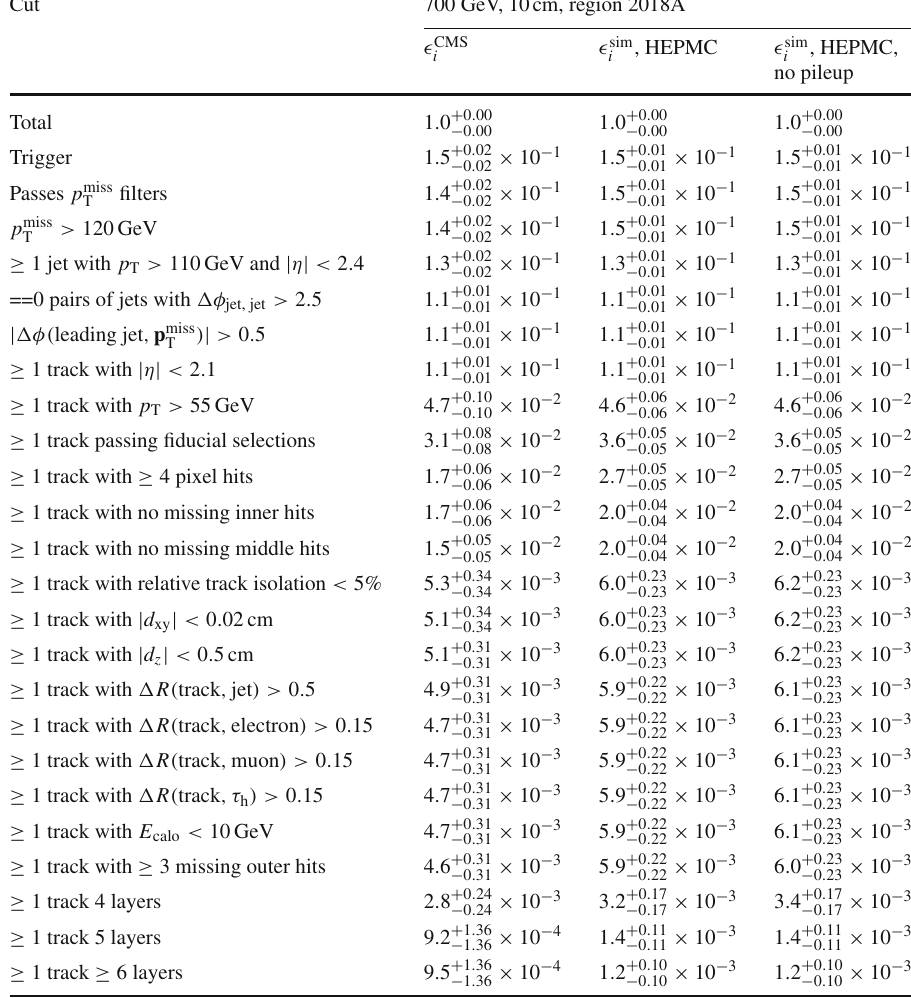
effect of pileup on the cutflows for 700 GeV, 10cm winos, region 2018A. “HEPMC” denotes processing of events stored in hepmc files